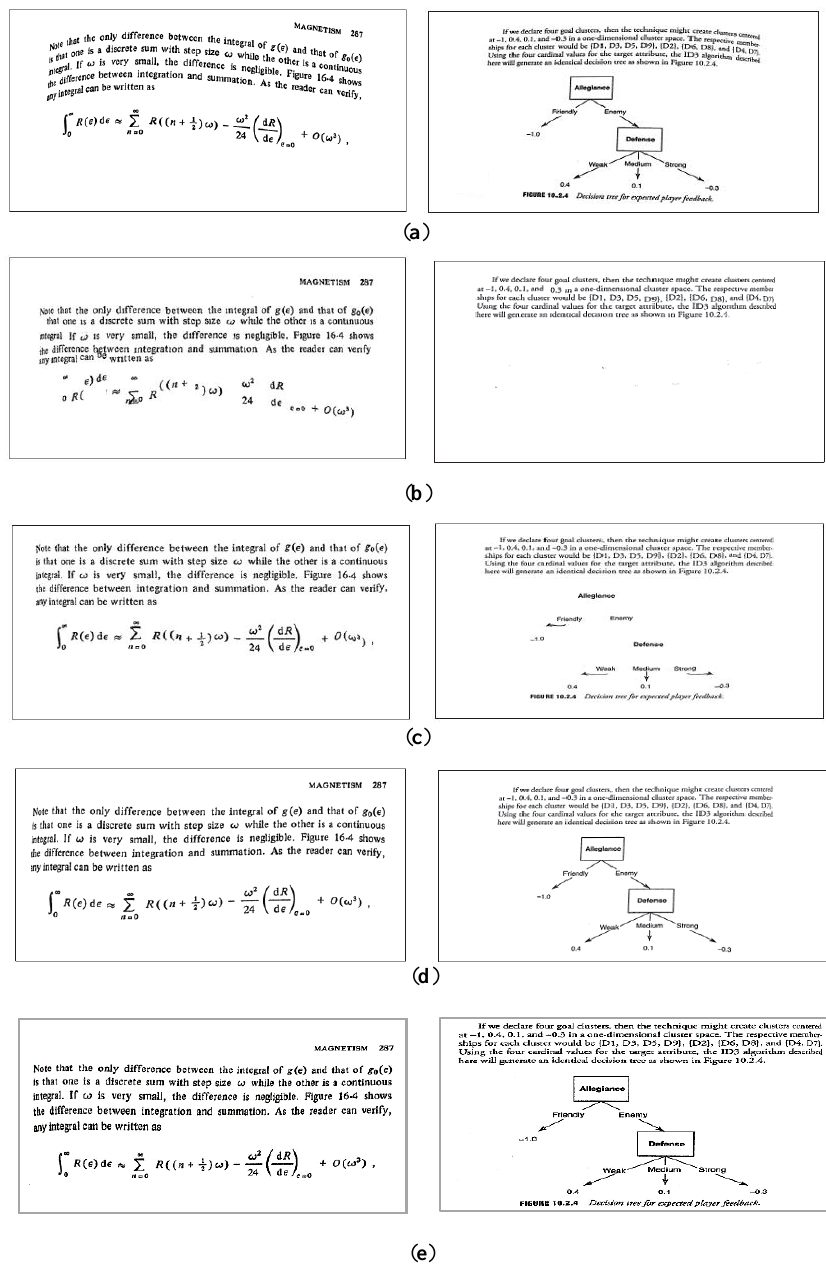
Figure 12. The comparison between our approach and other state-of-the-art methods using CBDAR dataset. ( a ) Original document images in CBDAR dataset. ( b ) Method proposed in [14]. ( c ) Method proposed in [4]. ( d ) Method proposed in [13]. ( e ) Our proposed method.